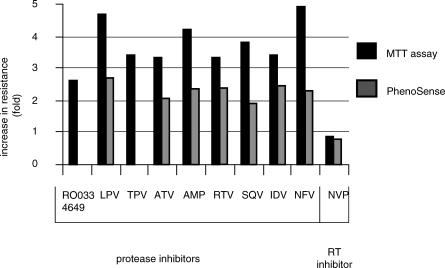
Determination of Phenotypic Drug Susceptibility of C-Terminal Gag ClonesRepresentation of the fold increases in phenotypic drug susceptibility of the C-terminal Gag clone derived from IVS-1, containing the 436E+437T amino acid change as compared to wild-type HIV (HXB2). The black bars indicate the fold increase as determined in the multiple-cycle MTT drug susceptibility assay, and the gray bars indicate the fold increase as determined in the single-cycle PhenoSense drug susceptibility assay. Drug susceptibility to the PI RO033-4649, LPV, TPV, ATV, AMP, ritonavir (RTV), saquinavir (SQV), indinavir (IDV), and nelfinavir (NFV), and as a control to the RT inhibitor NVP was determined. RO033-4649 and TPV were not available at the time of PhenoSense assay testing.